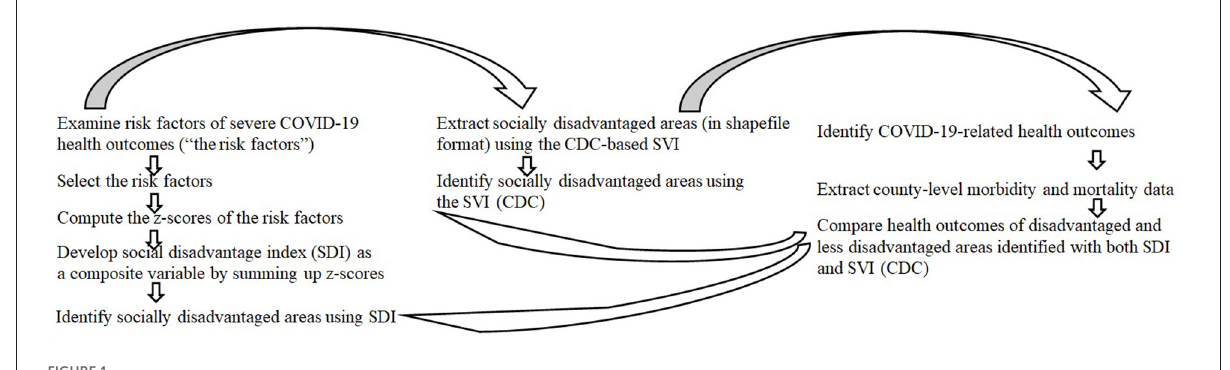
FIGURE1 A methodological flowchart for this